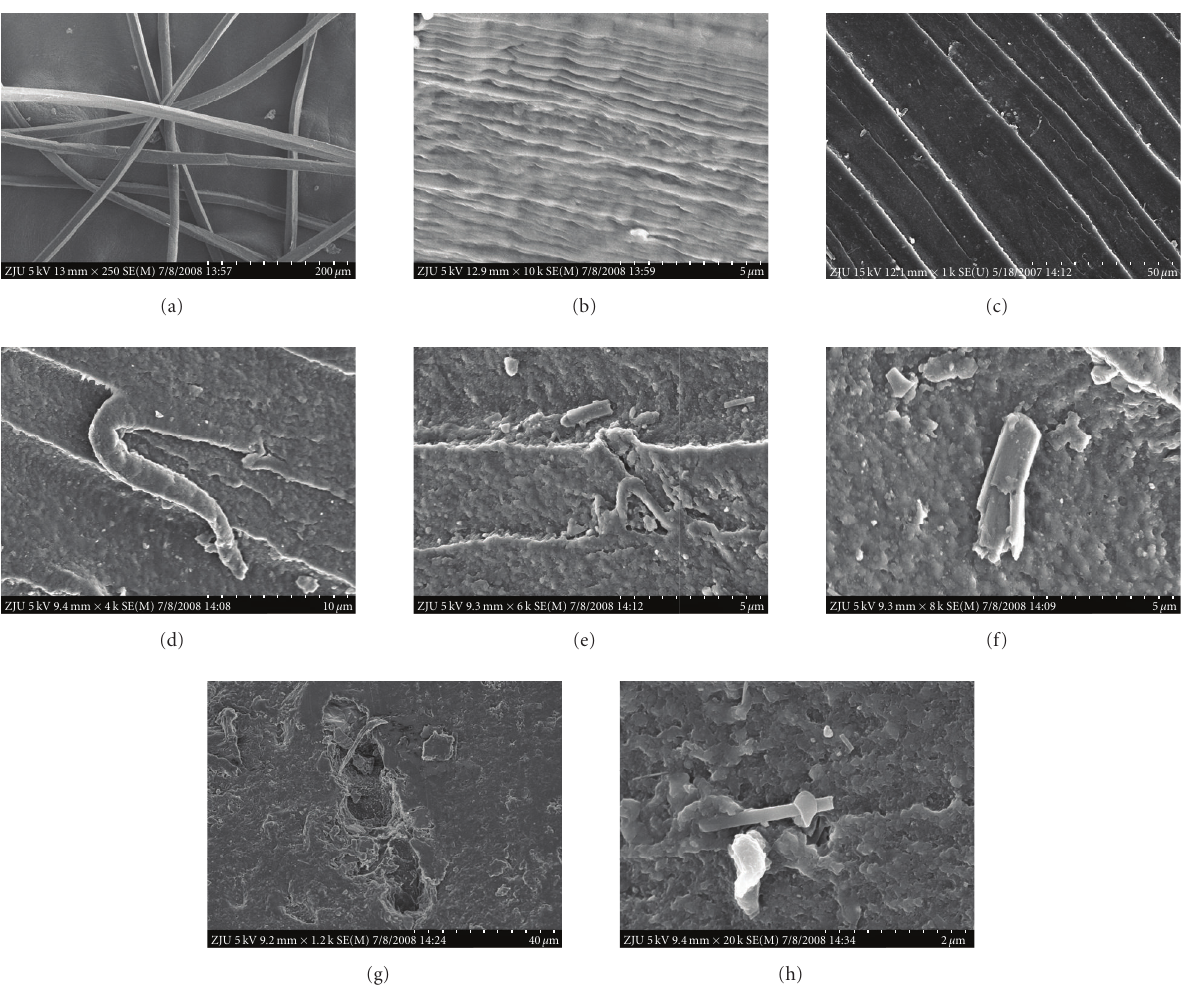
Figure 5: SEM micrographs of (a) CHF ( × 250), (b) CHF ( × 10,000), (c) CS rod ( × 1000), (d) CHF/CS (0.25/100, wt/wt) ( × 4000), (e) CHF/CS (0.5/100, wt/wt) ( × 6000), (f) CHF/CS (0.5/100, wt/wt) ( × 8000), (g) CHF/CS (1/100, wt/wt) ( × 1200), and (h) CHF/CS (1.5/100, wt/wt) ( ×